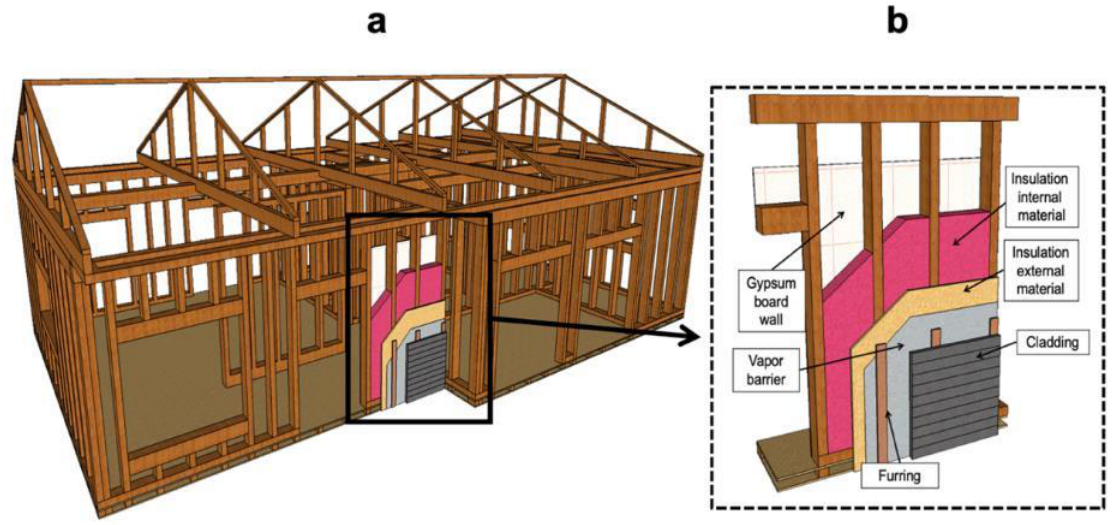
Figure 2. Wood frame schematic drawing: ( a ) wood-frame structure ( b ) details of wood-frame walls based on documents from Canada Mortgage and Housing Corporation [115] and the American Wood Council [119].